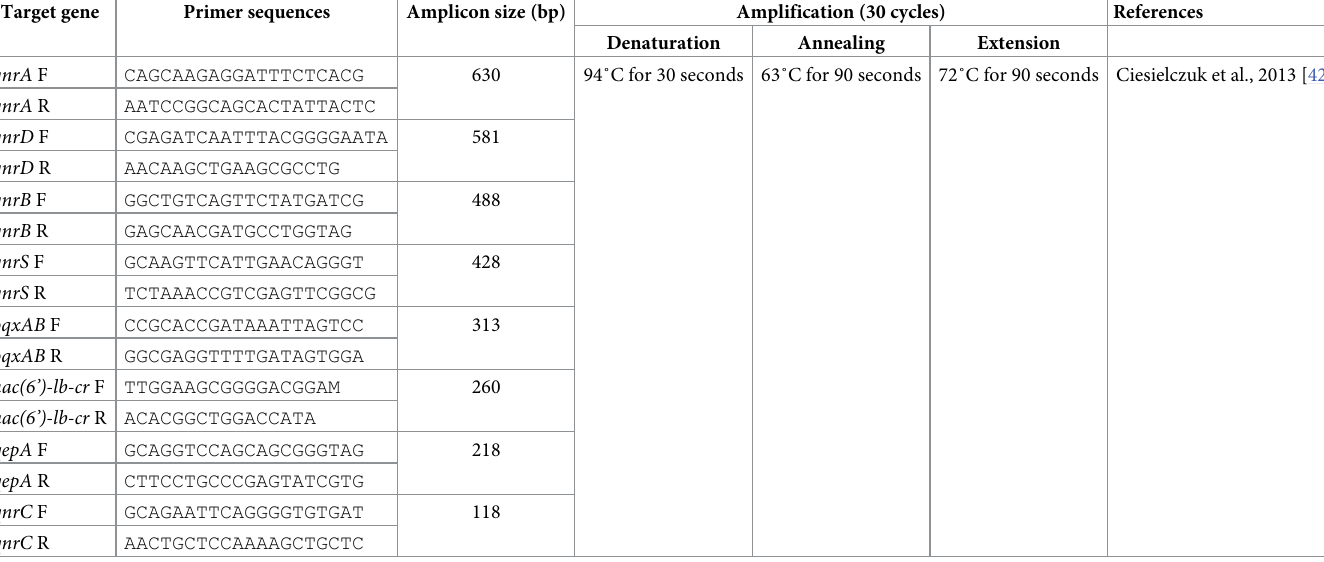
Table 1. List of primer sequences used in multiplex PCR for the determination of PMQR determinants. Target gene Primer